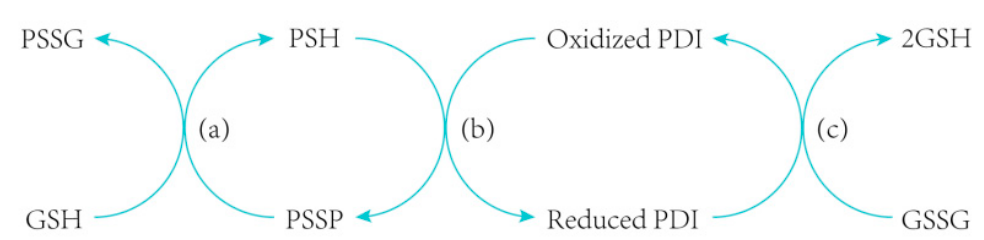
Figure 6. Schematic presentation of gluten disulfide crosslink. Glutathione (GSH) reacts with disulfide bonds within glutenin, allowing the protein to depolymerize ( a ). However, oxidized PDI can catalyze the formation of disulfide bonds in gluten and thus strengthen the gluten ( b ). The reduced PDI produced by the reaction ( b ) can be oxidized by oxidized glutathione (GSSG) to generate GSH ( c ). PSSG represents crosslinked product of GSH and gluten peptide. PSH and PSSP represent sulfhydryl-containing gluten peptide and cross-linked products between glutens, respectively.